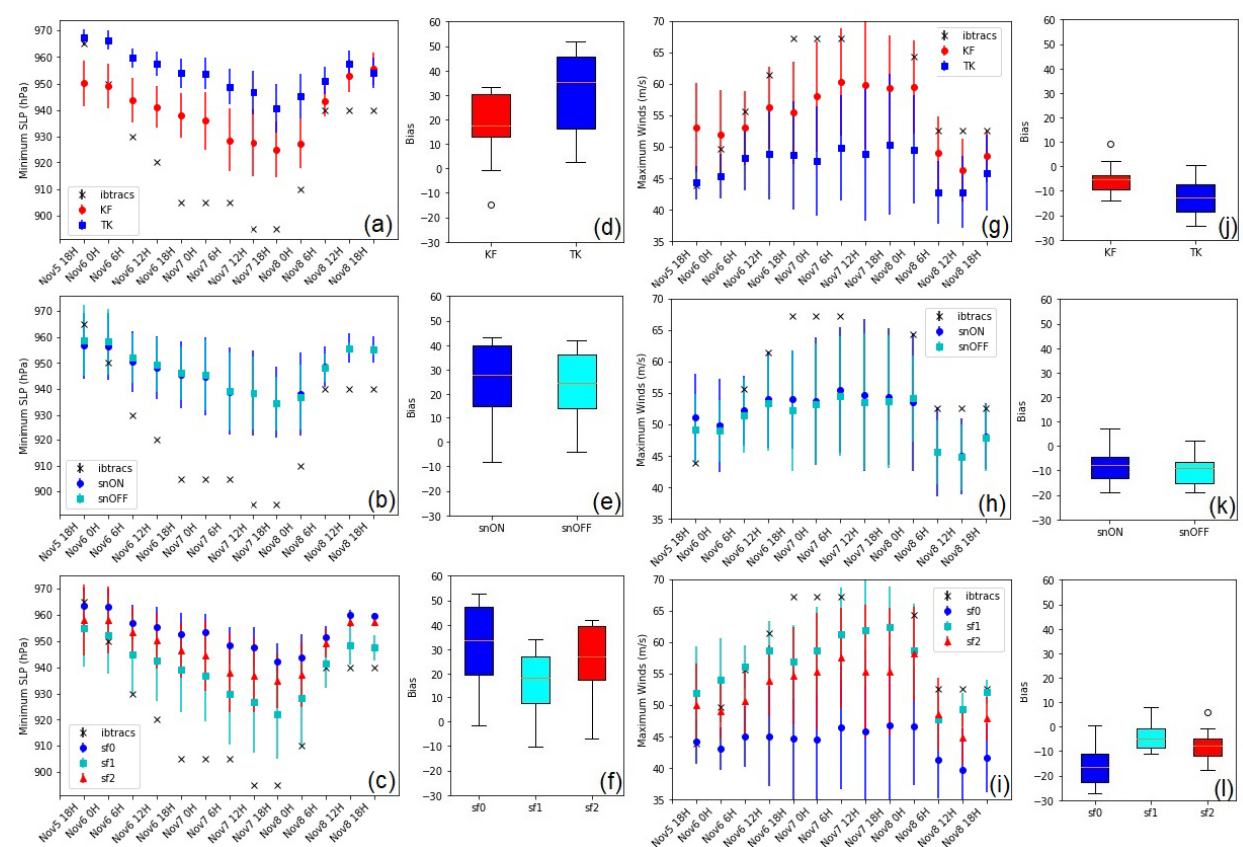
Figure 5. Time series of the mean intensities and standard deviations (a–c) for MSLP and (g–i) for maximum winds, with mean biases for MSLP (d–f) (hPa) and maximum winds (ms − 1 ) for each group (j–l) for cumulus schemes KF and TK, spectral nudging, and for surface flux options. The x axis is the analysis period between 18:00UTC on 5 November 2013 and 18:00UTC on 8 November